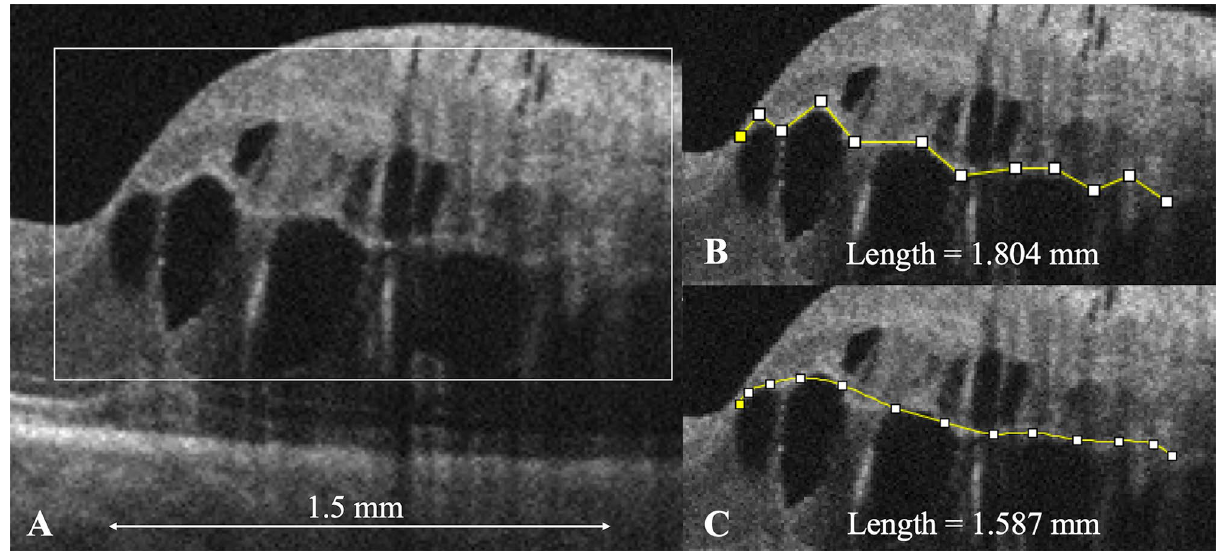
Figure 5. The jaggedness of the border between the inner nuclear layer (INL) and the outer plexiform layer (OPL) in eyes with macular edema (ME) secondary to branch retinal vein occlusion. ( A ) At the initial visit, an optical coherence tomography (OCT) vertical scan through the fovea shows ME. ( B,C ) Magnified images of the box in ( A ). ( B ) We manually traced the border (segmented line) between the INL and OPL on the images within 1.5 mm from the fovea using ImageJ software. The border length in this case was 1.804 mm. ( C ) We also manually drew a spline curve through the middle points of the border using the “Spline Fit” mode in the software and measured its length (1.587 mm). The jagged ratio (JR) then was calculated as the border length/ spline curve length; the JR is 1.14 in this case. Figure is created using ImageJ software version 1.53a (National